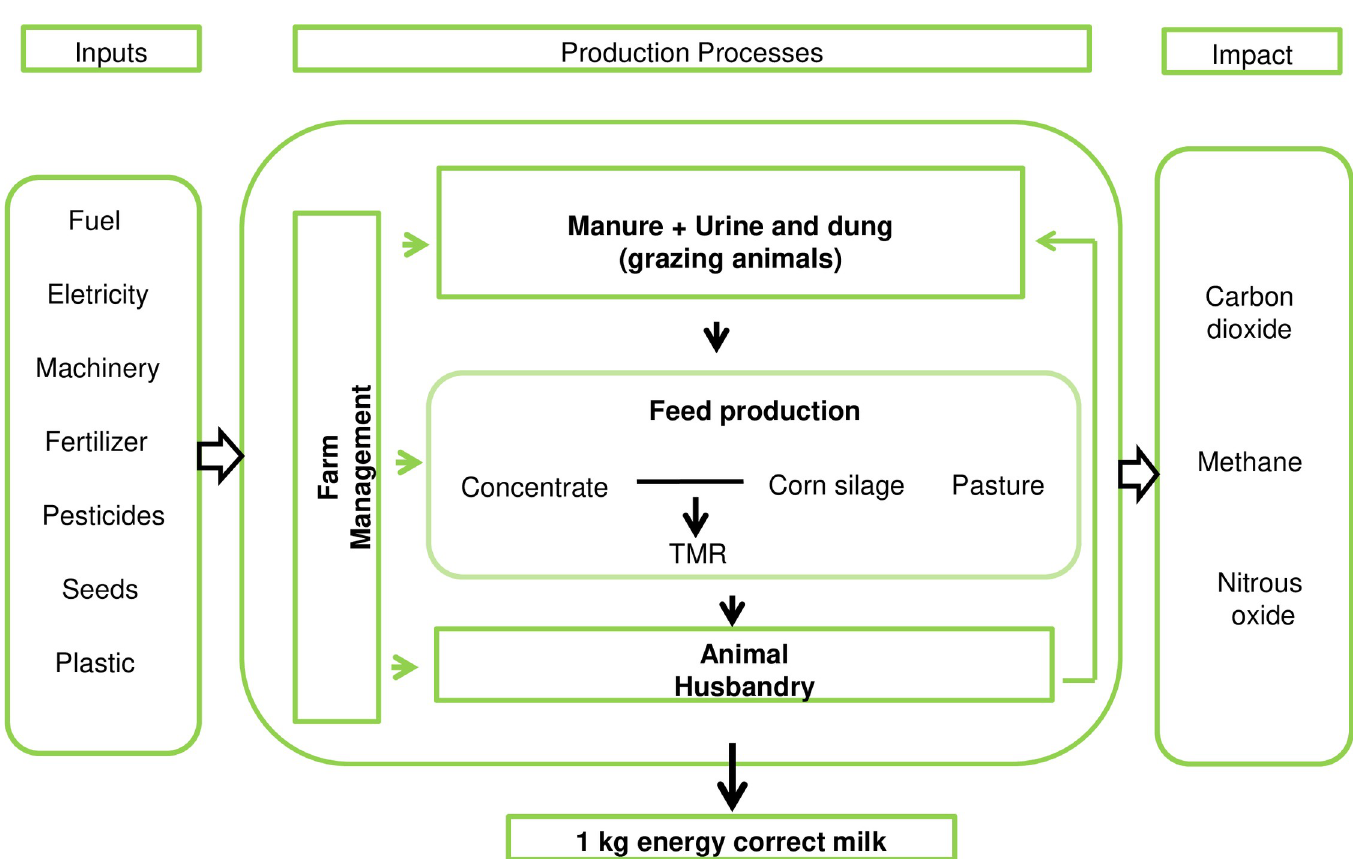
Fig 1. Overview of the milk production system boundary considered in the